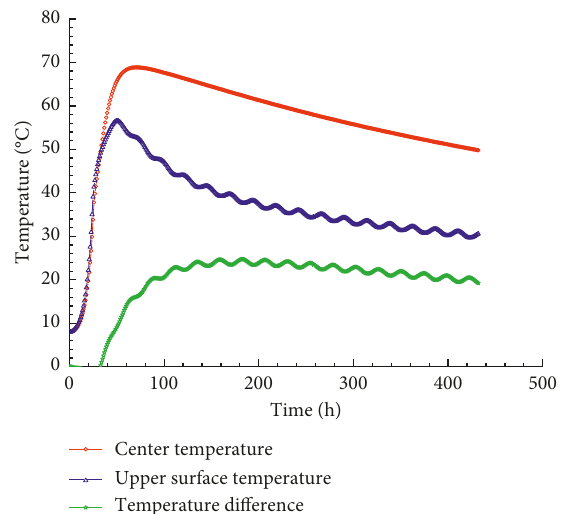
Figure 17: Temperature difference between the core and the upper surface of the 2.5 m thick foundation.